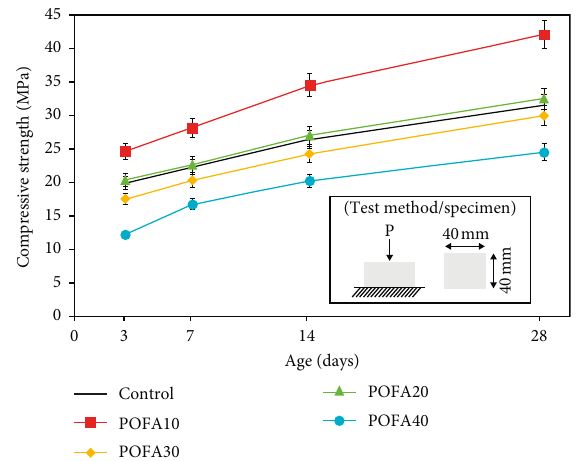
Figure 4: Compressive strength of mortars containing mPOFA.